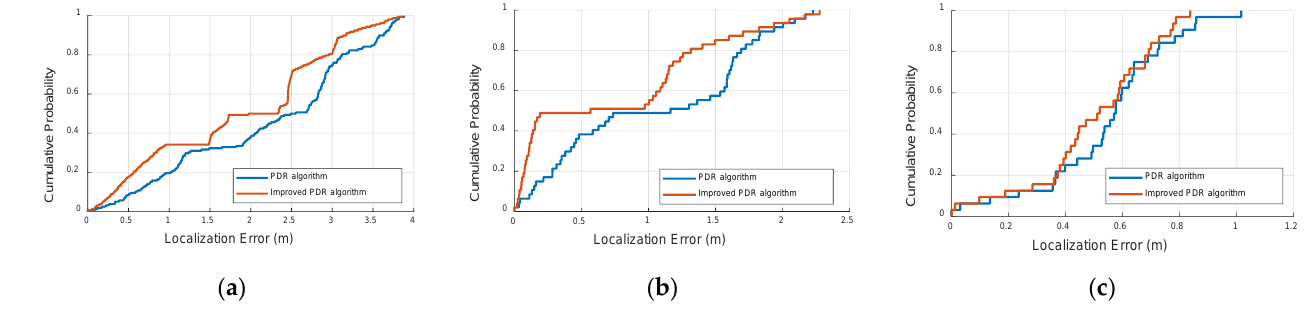
Figure 11. CDF of localization errors between the improved PDR and traditional PDR method at three sites. ( a ) First scene, ( b ) Second scene, ( c ) Third scene.